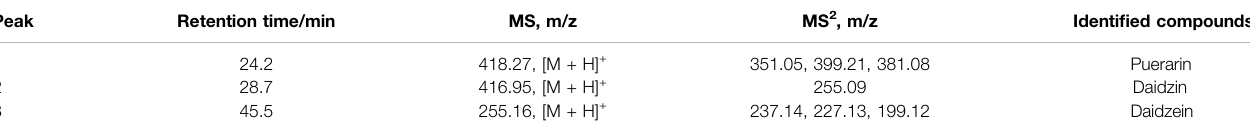
TABLE 1 | The MS-MS fragmentation patterns of the iso fl avonoids extracted from the Pueraria lobate Radix. Peak